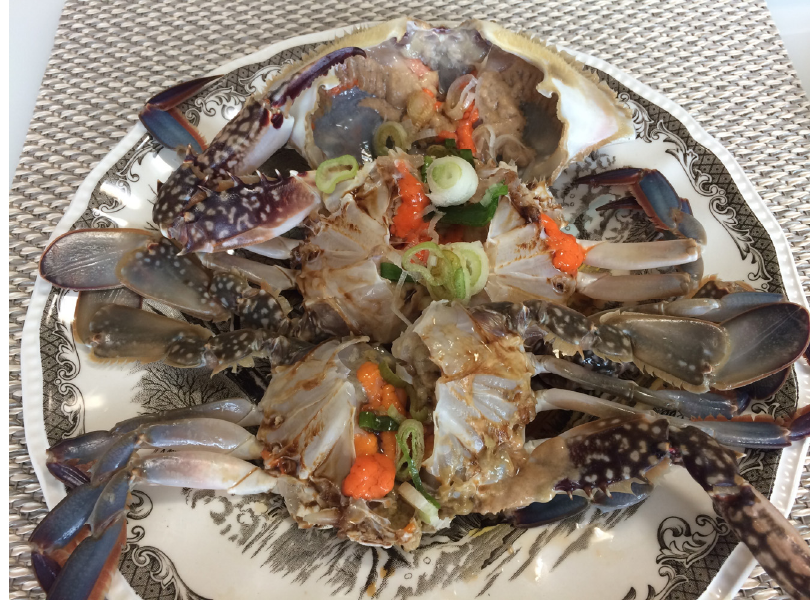
Figure A3. Ingredients: crab, soy sauce, mirin, garlic, chili, pepper, ginger, kelp, anchovy; see recipe at: http://www.maangchi.com/recipe/ganjang ‐ gejang.